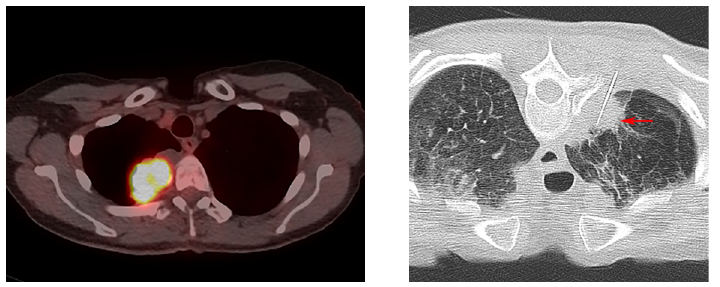
Fig 3. Example of likelihood of adequacy score 3 (high). (A) PET/CT showingright lung lesion that is large and FDG avid. Also, there is no aerated lung in the planned biopsy path. (B) Arrow points to needlein right lung mass.